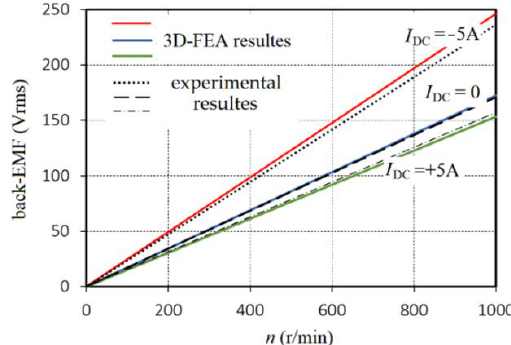
Figure 7. No-load phase voltage characteristics for three cases of I DC current load.